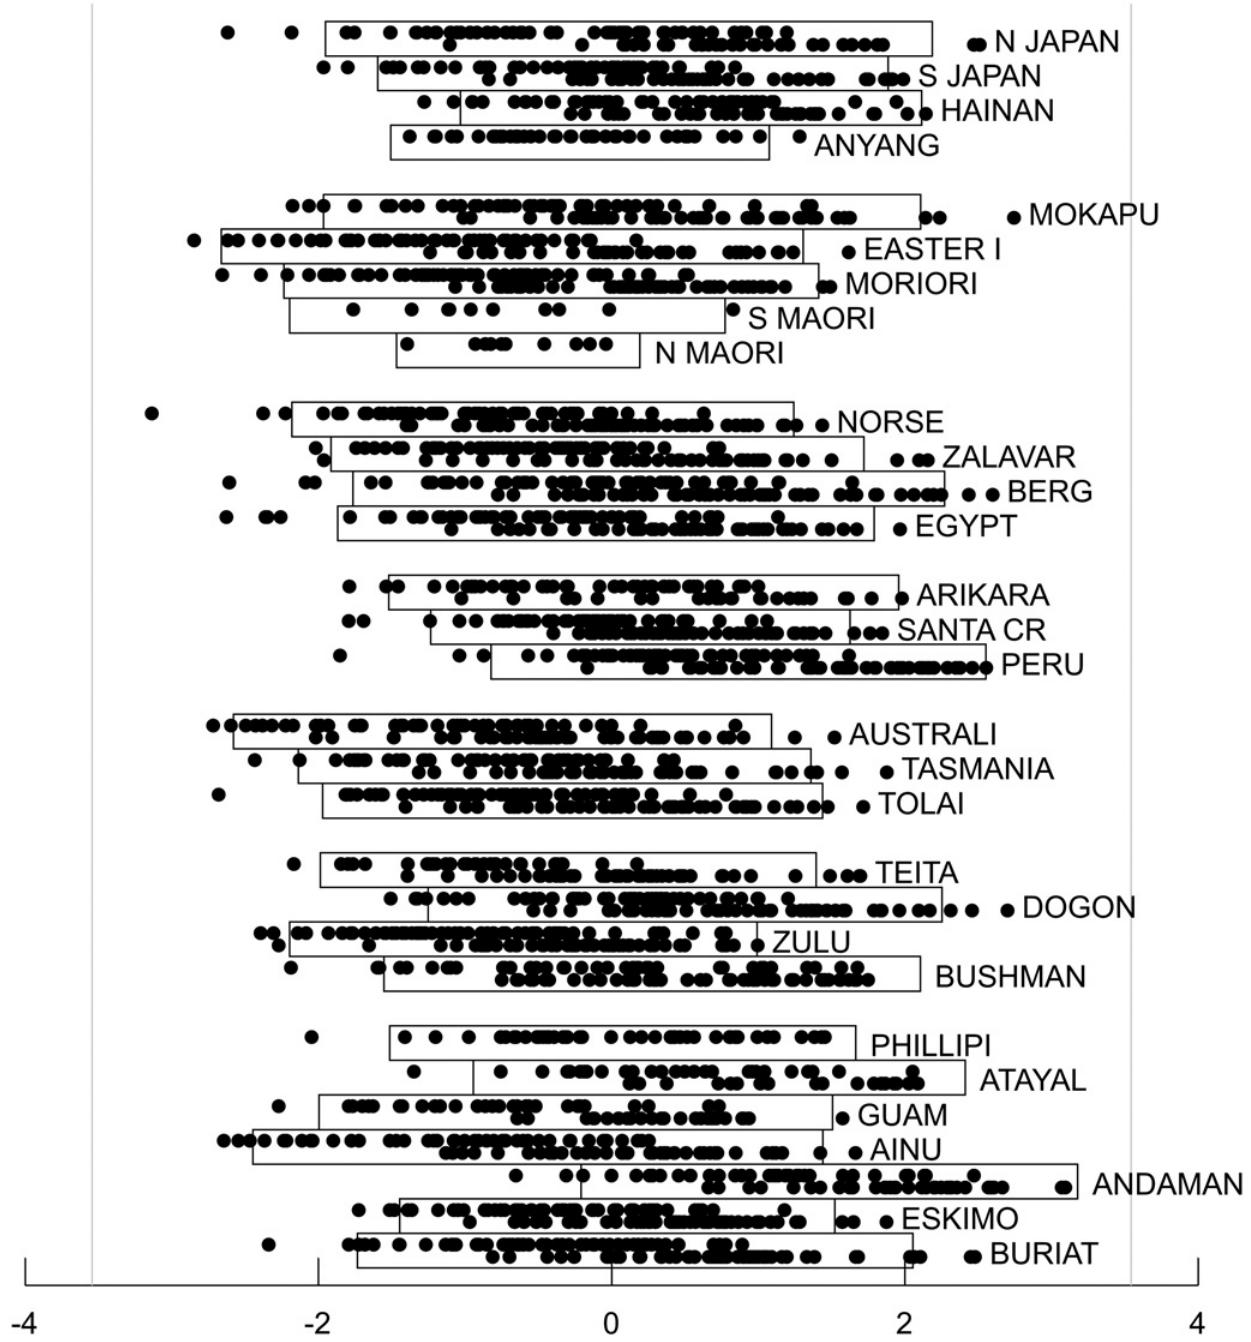
Fig 10. First principal component of the craniometric data six dimensional Gaussian subspace. Component scores are derived from the best fitting model. This component accounts for 20.0% of the variance of the original data set. See Fig. 6 legend for additional details.